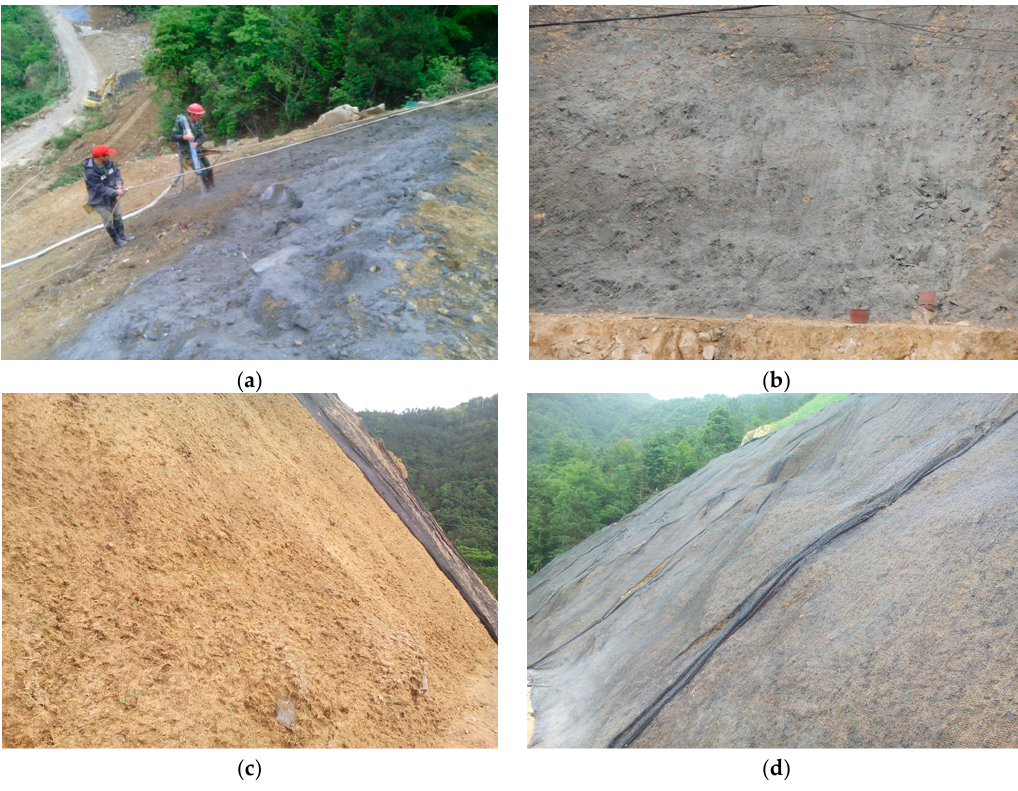
Figure 12. Construction of polymer curing agent for weak rock slope: ( a ) Spraying; ( b ) construction of wire mesh; ( c ) external-soil spray-seeding; ( d ) curing.